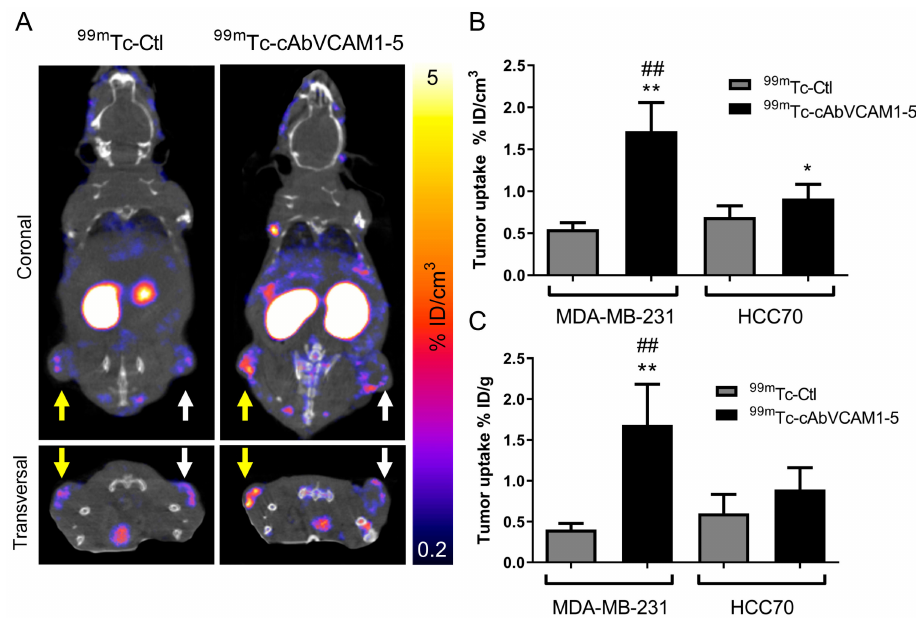
Figure 3. In vivo biodistribution of 99m Tc-cAbVCAM1-5 in mice bearing HCC70 and MDA-MB-231 tumor xenografts. ( A ) Representative coronal and transversal views of fused SPECT / CT images of HCC70 (right hind limb, white arrow) and MDA-MB-231 (left hind limb, yellow arrow) tumor-bearing mice at 1 h after i.v injection of 99m Tc-cAbVCA1M-5 or 99m Tc-Ctl. ( B ) In vivo quantification of 99m Tc-cAbVCAM1-5 and 99m Tc-Ctl tumor uptake from SPECT images. ( C ) Ex vivo quantification of 99m Tc-cAbVCAM1-5 and 99m Tc-Ctl tumor uptake from post-mortem biodistribution studies. Results were expressed as % ID / cm 3 (imaging) and % ID / g (ex vivo) of tumor. Statistics: * p < 0.05, ** p < 0.01 vs. 99m Tc-Ctl; ## p < 0.01 vs. HCC70.